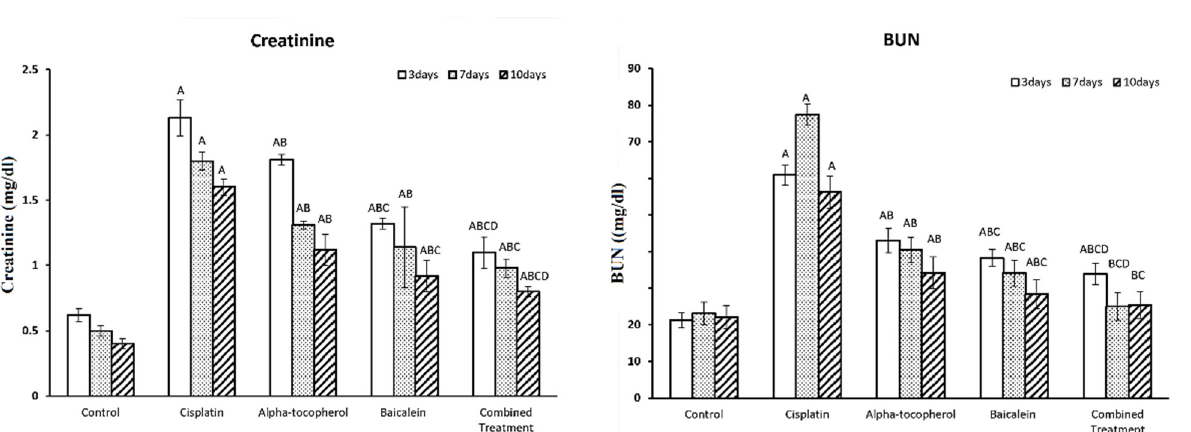
Figure 2. Impact of α -tocopherol and baicalein administration on kidney function. All data are ex- pressed as mean ± SEM. Significant vs. control group refers to A, while significant vs. (cisplatin, - tocopherol, and baicalein) treatment groups refers to (B, C, D), respectively.